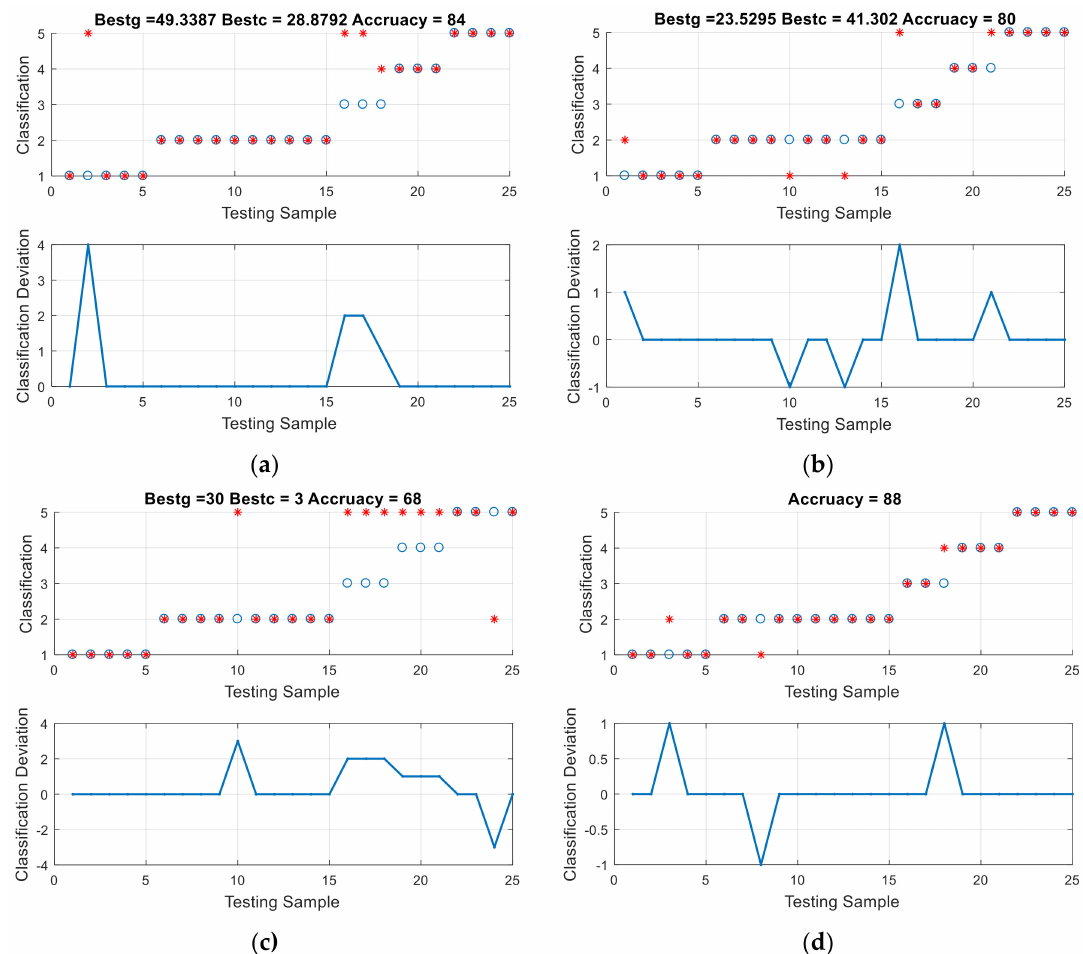
Figure 12. Fault diagnosis results and the spatial distribution of the optimal solution using different methods ( a ) PSO–SVM; ( b ) GA–SVM; ( c ) SVM; ( d )